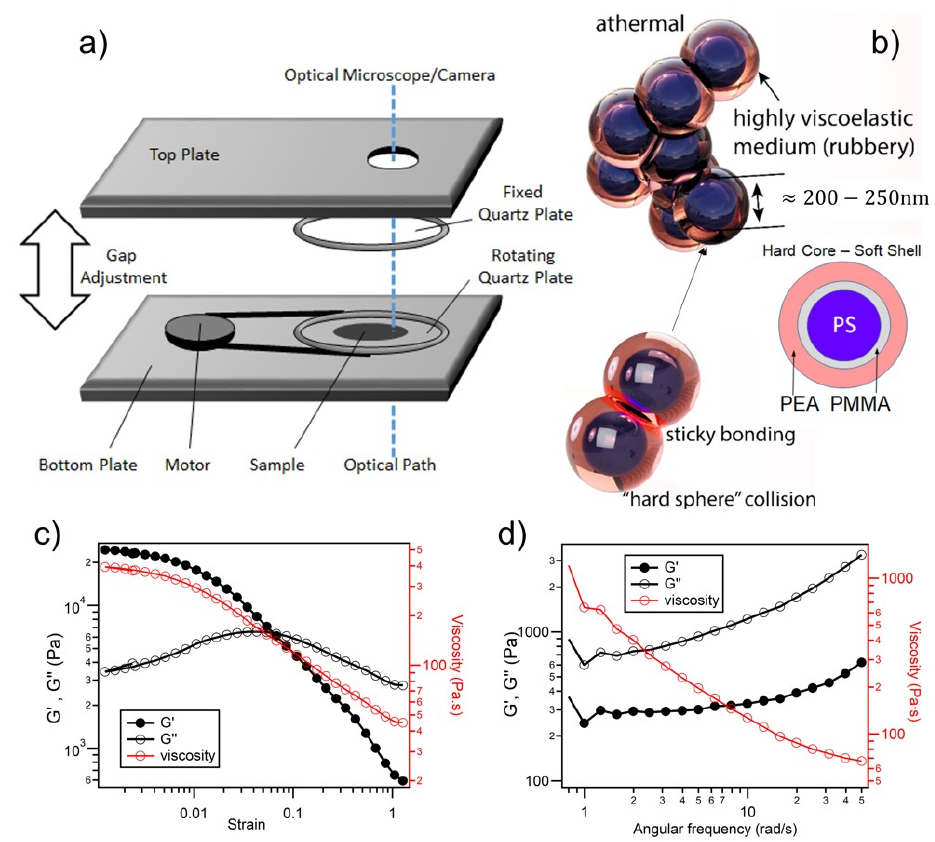
Figure 1. Schematic of an optical shear cell is shown in ( a ), with the optical path through the windows and cell, allowing real-time capture of transmission spectra, also illustrated. The composite core–shell structure, consisting of polystyrene (PS), poly-methylmethacrylate (PMMA) and poly-ethylacrylate (PEA) is shown in ( b ), together with a schematic of the ensemble interactions as particles form macroscopic polymer opal arrays. In ( c , d ), the measured storage (G (cid:48) ) and loss (G (cid:48)(cid:48) ) moduli for the polymer opal material are given, together with the inferred viscosity. Strain dependence is shown in ( c ) at a 5 Hz frequency; angular frequency dependence is shown in ( d ) at 100% strain amplitude. Rheometric measurements are taken using an AR-2000 oscillatory rheometer (TA instruments), in a cone-and-plate geometry (radius 2 cm, angle = 1 ◦ , working gap = 27 mm). Image elements of part ( b ) have previously appeared under CC-BY license in reference